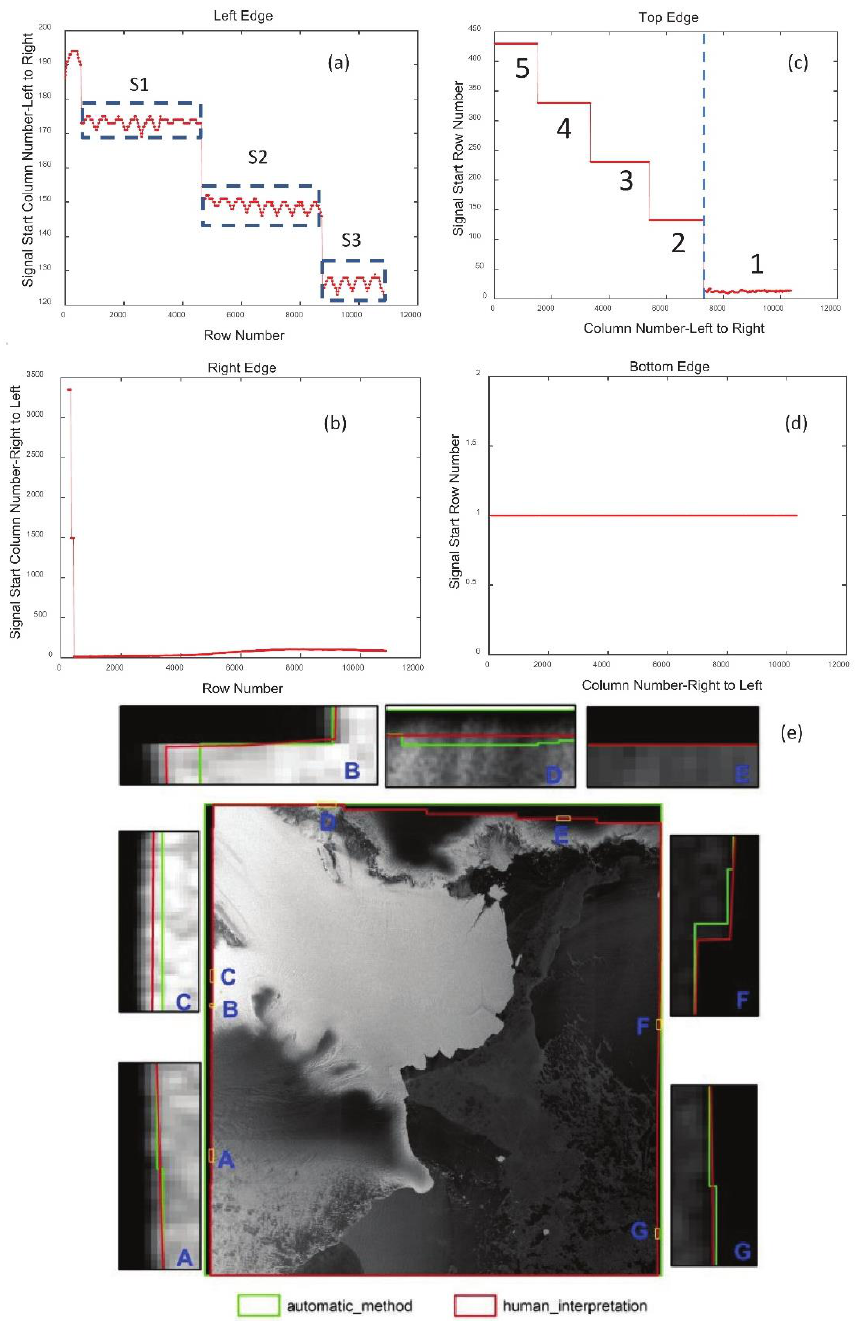
Figure 6. BM edge extraction and results comparison between automatic method and human interpretation. ( a – d ) correspond to BM edges from the left, right, top, and bottom of ( e ). Blue dashed squares in ( a ) indicate di ff erent edge steps. ‘S1’, ‘S2’, and ‘S3’ are respectively used for analysis in Figure 9a,c,e. ‘1’ to ‘5’ correspond to BM edges from five sub-swaths as indicated in Figure 2. Vertical dashed blue lines indicate boundaries of data gaps as can be seen from Figure 2. ( e ) Comparison of BM edge extracted with automatic method (green) and human interpretation (red). Comparison zooming in is marked with ‘A’ to ‘G’. Plotted with image coordinates, thus di ff ering from Figure 2. The image flipping is caused by SAR imaging